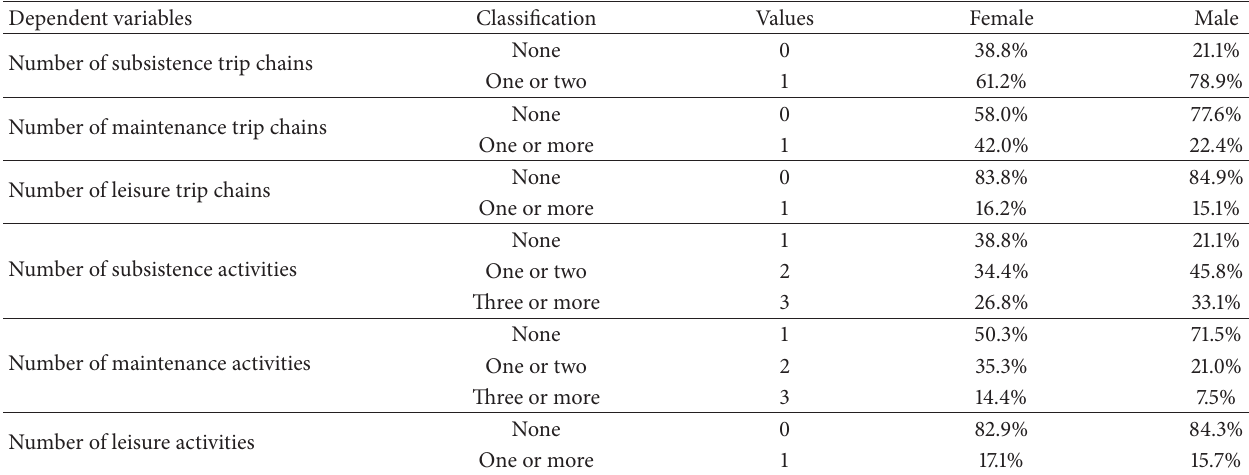
Table 3: Classifications and values of independent